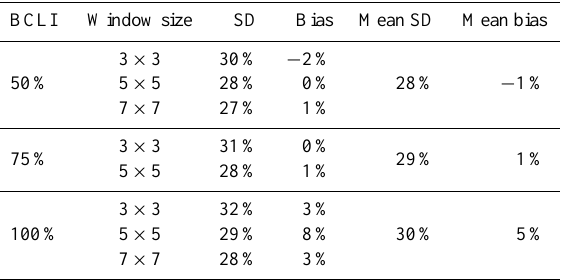
Table 8. Standard deviation (SD) and bias (as well as mean SD and mean bias) between HSI and SEVIRI as a function of different broken-cloud layer indexes (BCLI = 50, 75 or 100%) and averaged window sizes (3 × 3, 5 × 5 and 7 × 7) in Hannover, Germany,